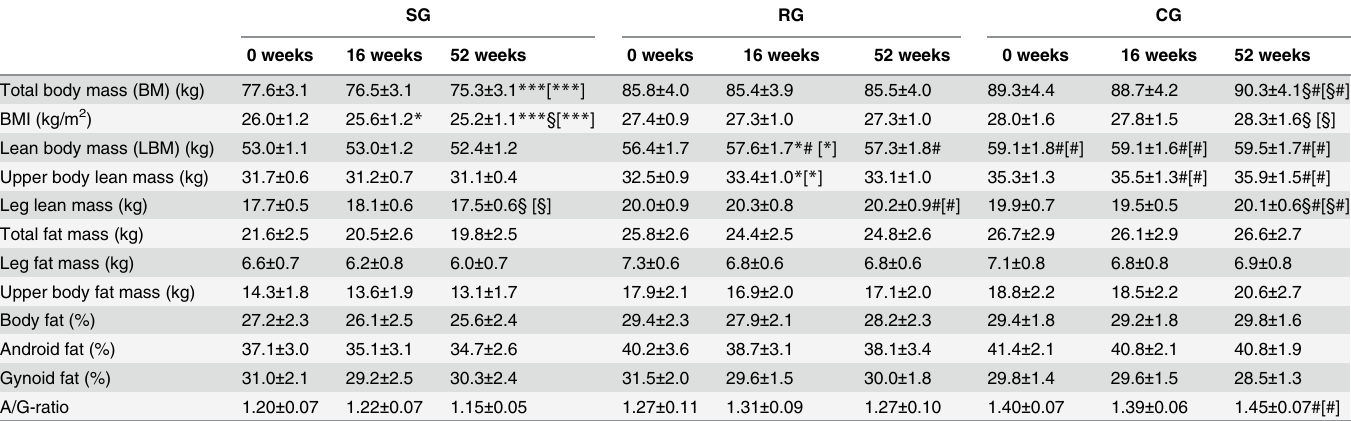
Table 2. Anthropometric characteristics during 52 wks of soccer or resistance training in elderly